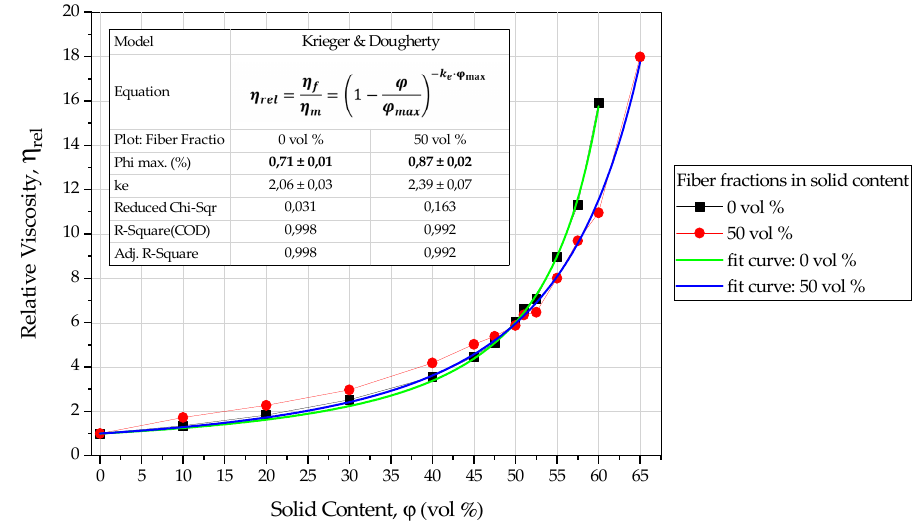
Figure 8. Relative viscosities for different shear rates versus solid content for the feedstocks with 0 and 50 vol % fibers in solid content.